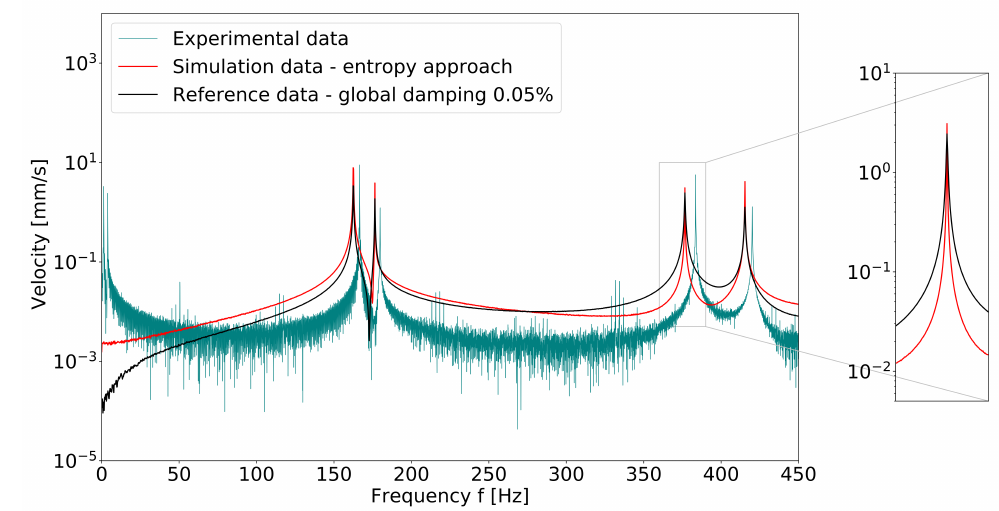
Figure 13. Comparison of velocity frequency spectrum of impulse-excited plate structure: experiment, simulation with global structural damping and simulation with modal damping. The velocity was measured/analyzed on a corner point of the